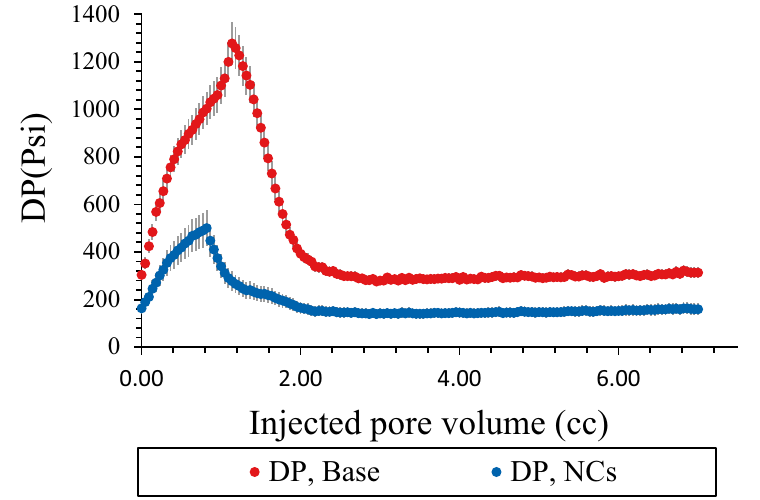
Figure 13. Differential pressure in the presence of NCs during CO 2 flooding.